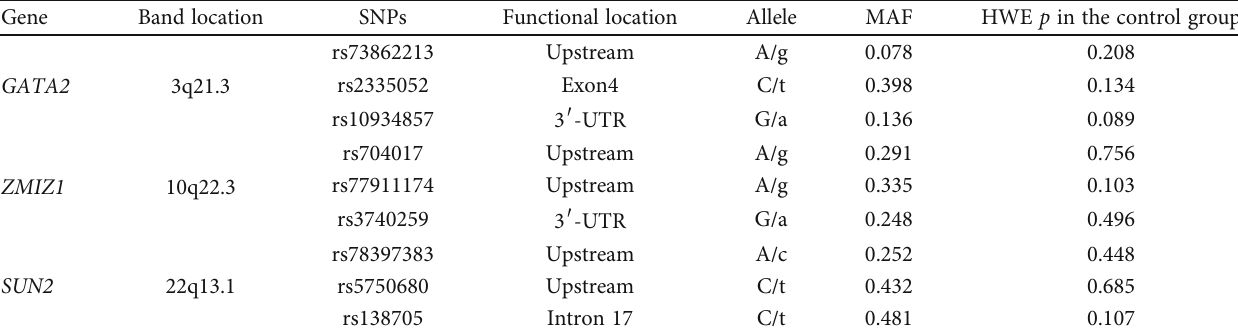
Table 1: SNPs in the GATA2 , ZMIZ1 , and SUN2 gene.